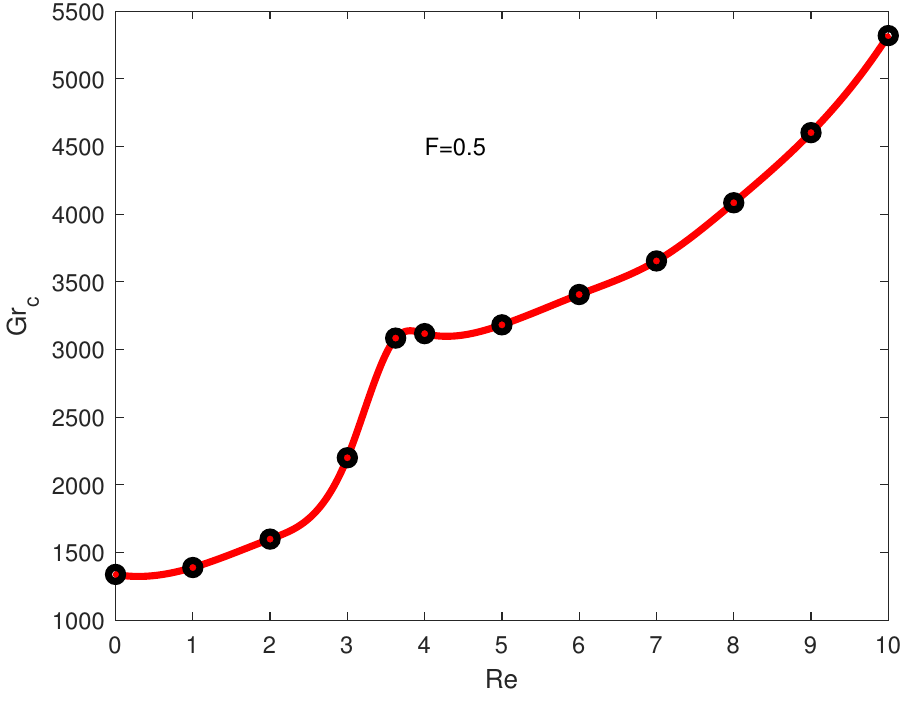
Figure 7. Critical Grashof numbers versus Re for F = 0.5. Critical wave numbers versus Re are shown in Figure 8. The finite jump at Re = Re ∗ is associated with the transition to perturbations with larger k as indicated in Figure